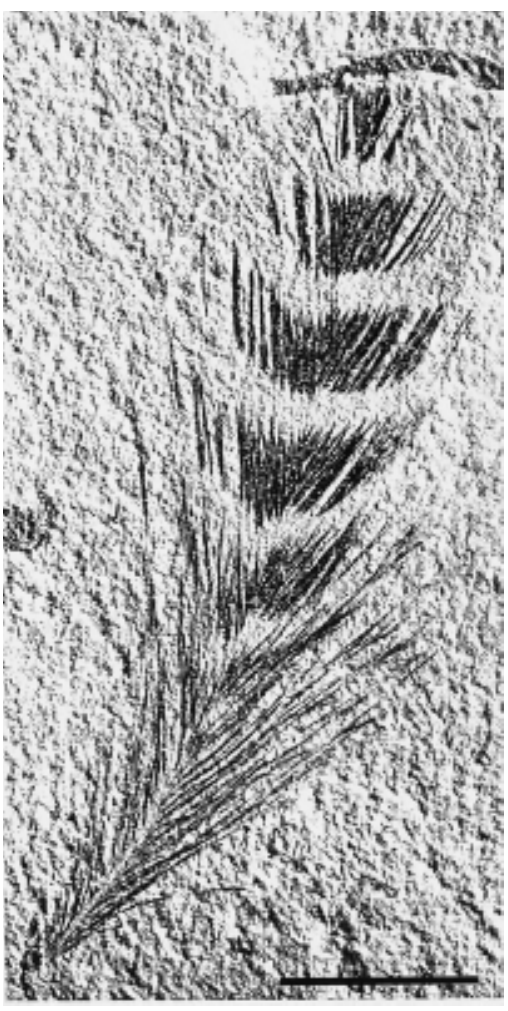
Fig. 18 – Contour feather from the Crato Member (Aptian), Santana Formation, Araripe Basin. Observe the dark and lighter bands, indicating the color pattern. Scale bar: